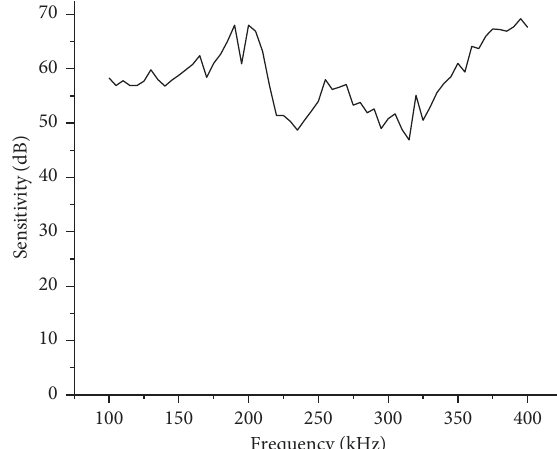
Figure 14: Schematic diagram of frequency response of PXR 50